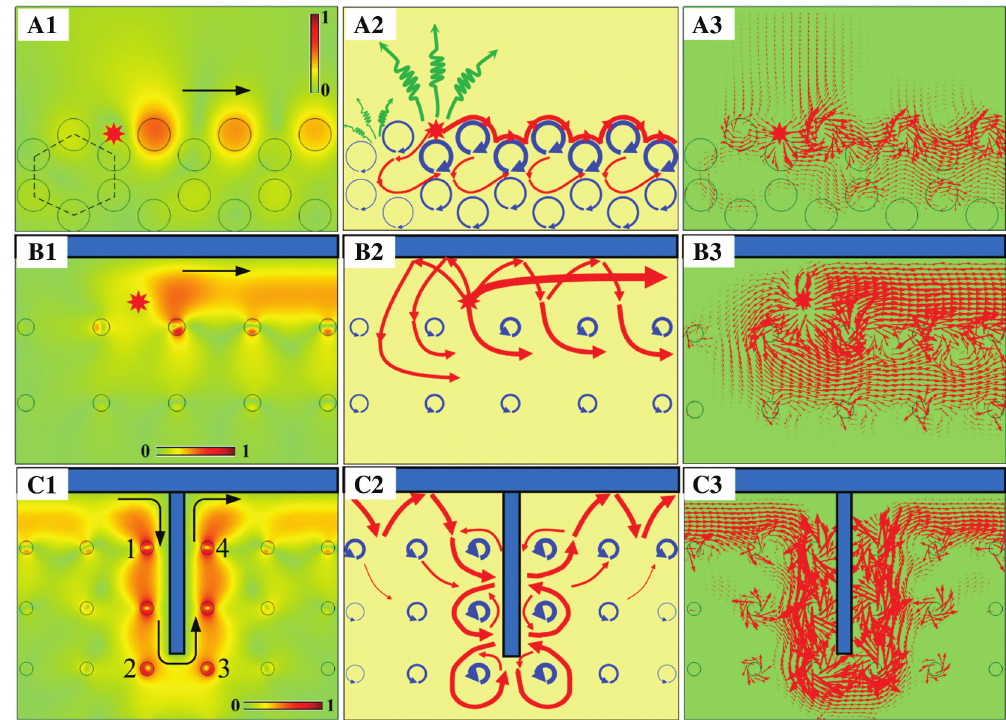
Figure 7: Topological photonic states in different MOPCs. (A1) open honeycomb MOPC, (B1) square MOPC waveguide, and (C1) square MOPC waveguide with an obstacle. The diagrams include the | E | distributions (A1, B1, C1), schematic diagrams (A2, B2, C2), and energy flux distributions (A3, B3, C3). The black arrows represent the transport direction, the blue arrows indicate the direction and intensity of the energy vortex around the magneto-optical rod, and the dark blue layers are the perfect electric conductor. The index 1–4 in (C1) means four critical magneto-optical rods (Rods 1–4) discussed in the main